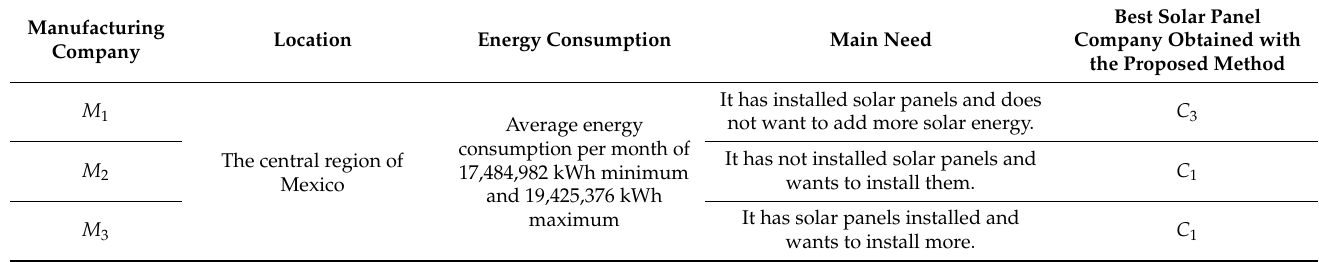
Best Solar Panel Company Obtained